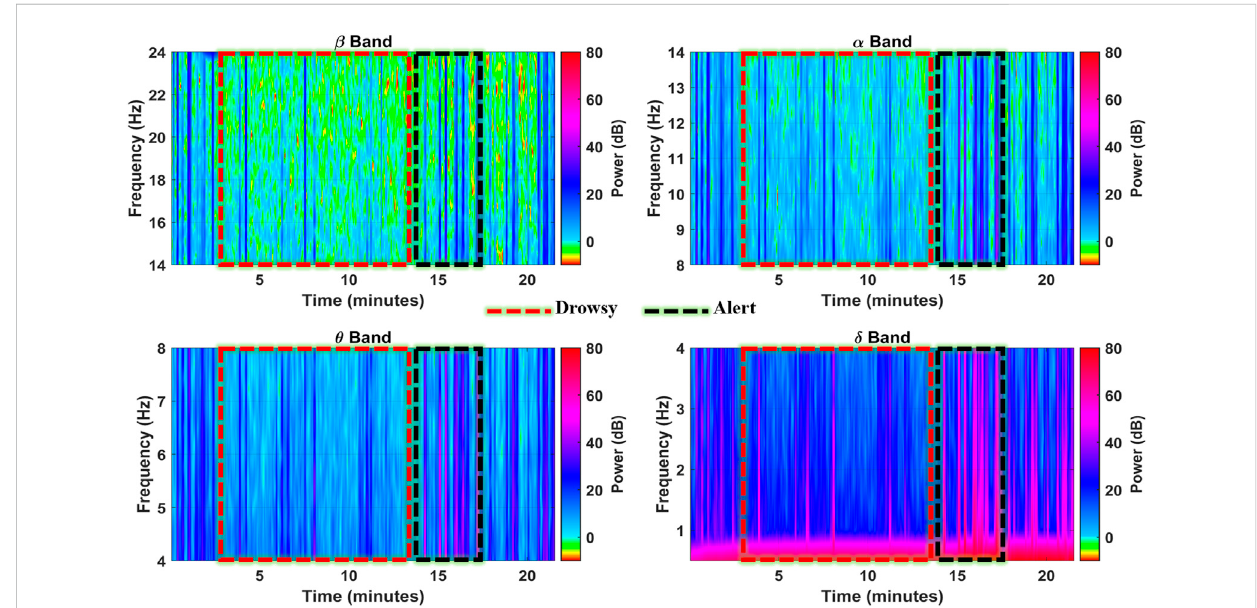
FIGURE 7 Spectrograms showing spectral band powers in individual EEG frequency bands in the F8 channel (subject 4).